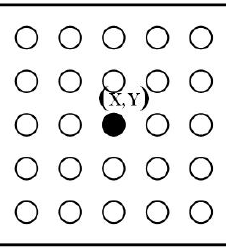
Figure 3. Example of 5 × 5 neighbourhood kernel of Kr